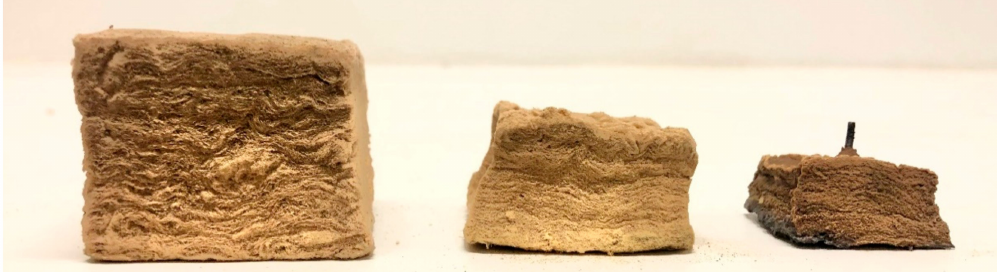
Figure 8. Test specimens after furnace heat treatments up to 1100 ◦ C (left), 1190 ◦ C (middle) and 1200 ◦ C (right), as seen from the side.